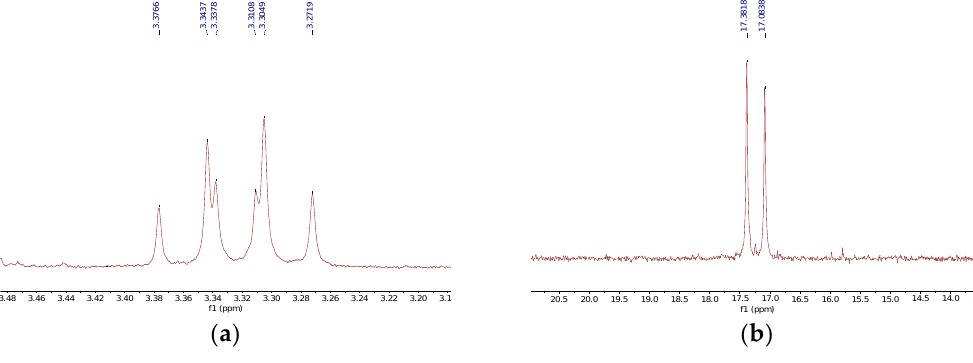
Figure 2. Fragments of 1 H NMR ( a ) and 31 P NMR ( b ) spectra that indicate the formation of the mono- and di-substituted products 2 and 3 .